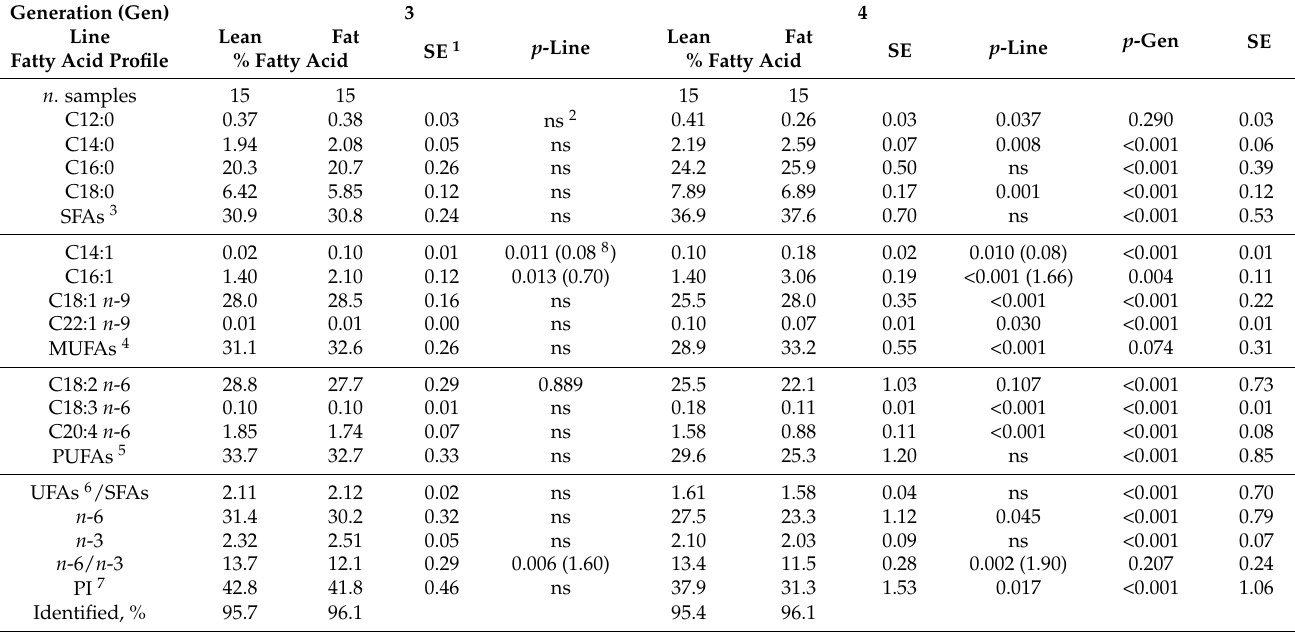
Table 4. Fatty acid profile (% of total FAMEs) of the forelegs of Lean and Fat rabbits in third and fourth generations of divergent selection for total body fat content.